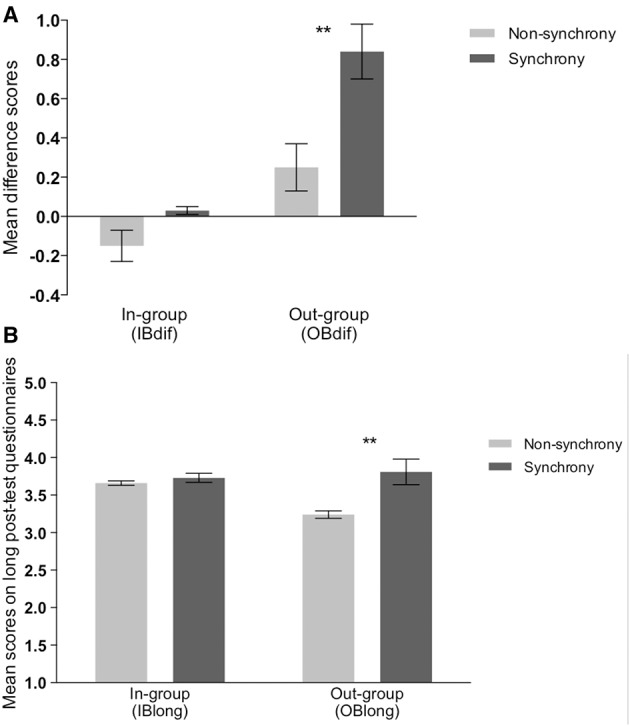
Mean scores on bonding questionnaires by condition. (A) Mean difference between pre-test and post-test questionnaire responses by condition. (B) Means of the long post-test questionnaire responses, IBlong and OBlong, by condition. **p < 0.05.